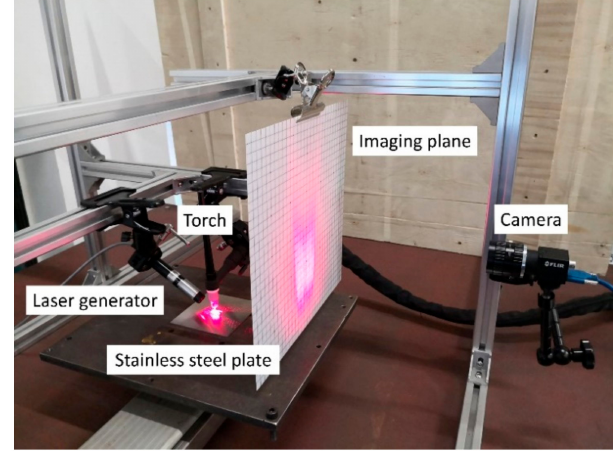
Figure 1. Experimental system.